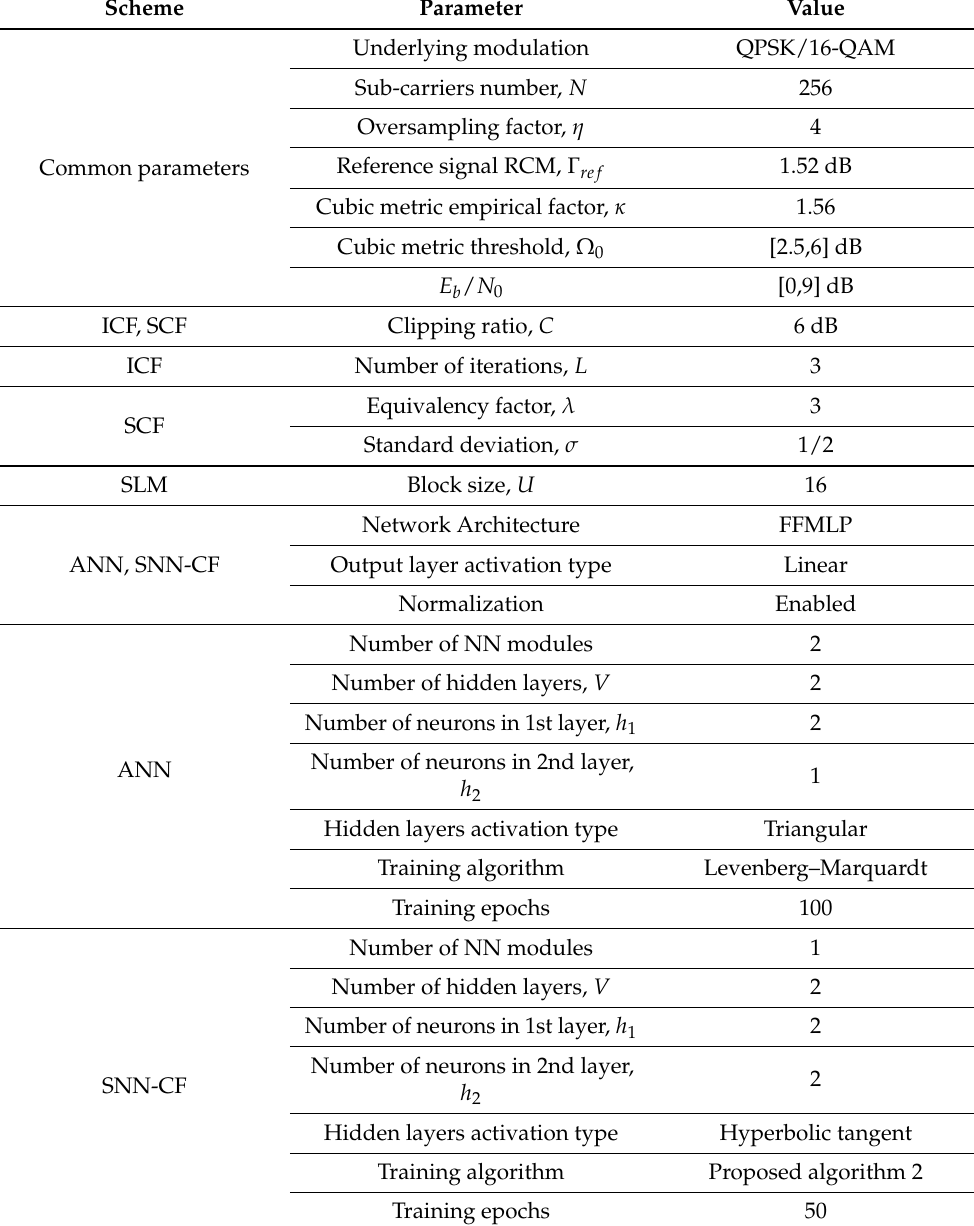
Table 2. Simulation